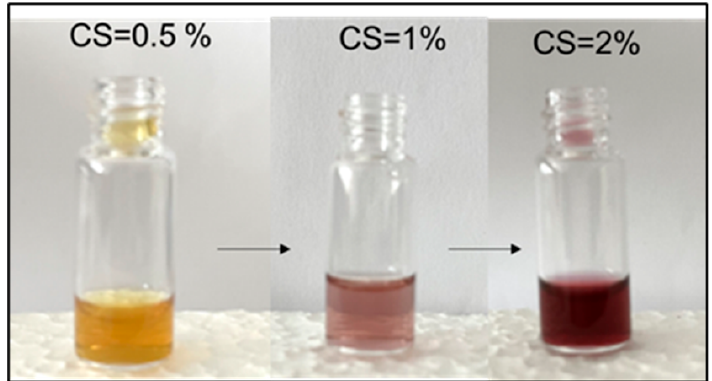
Figure 2. Color change in HAuCl 4 solution (1 mM) modifying CS concentration.